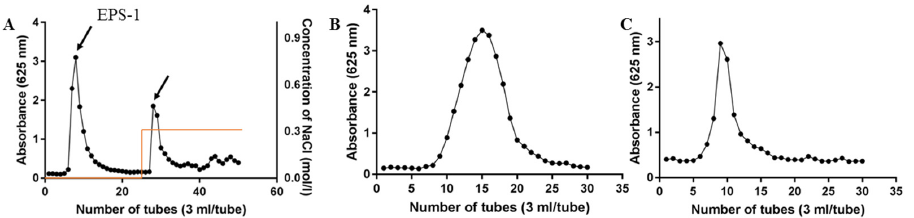
Figure 2. Isolation and purification of exopolysaccharides from the fermentation broth of R. nigri ‐ cans . ( A ) Crude polysccharides were stepwise separated by DEAE ‐ 52 ion exchange column; ( B ) Se ‐ phadex G ‐ 100 column; ( C ) Sephadex G ‐ 75 column.